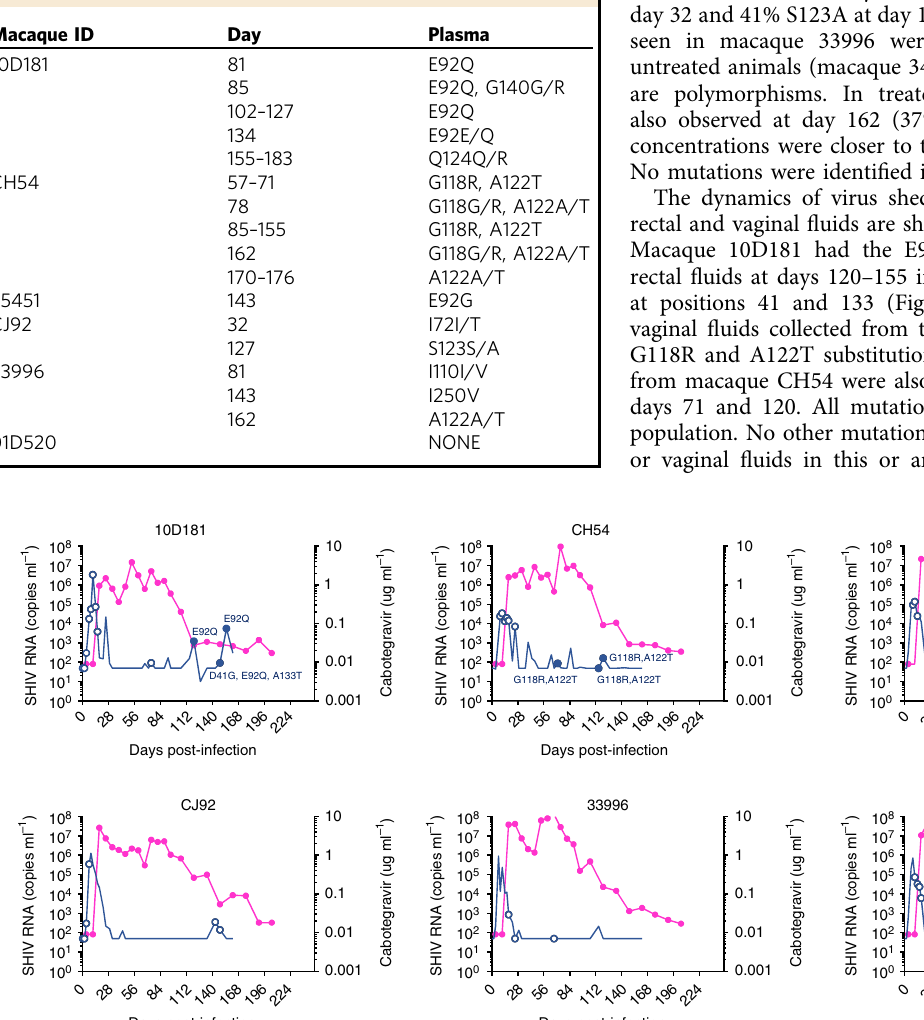
Table 1 Integrase mutations selected in plasma during CAB LA treatment